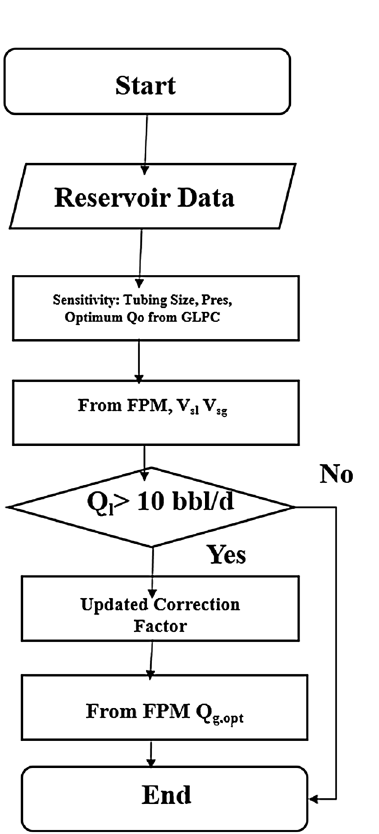
Fig. 4 Flowchart for FPM and correction factor utilization